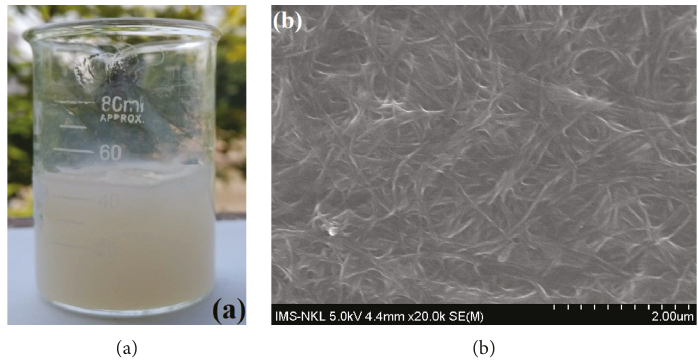
Figure 6: Scanning electron microscope images of bacterial cellulose treated by sonication at 65 ° C (b), BC/H